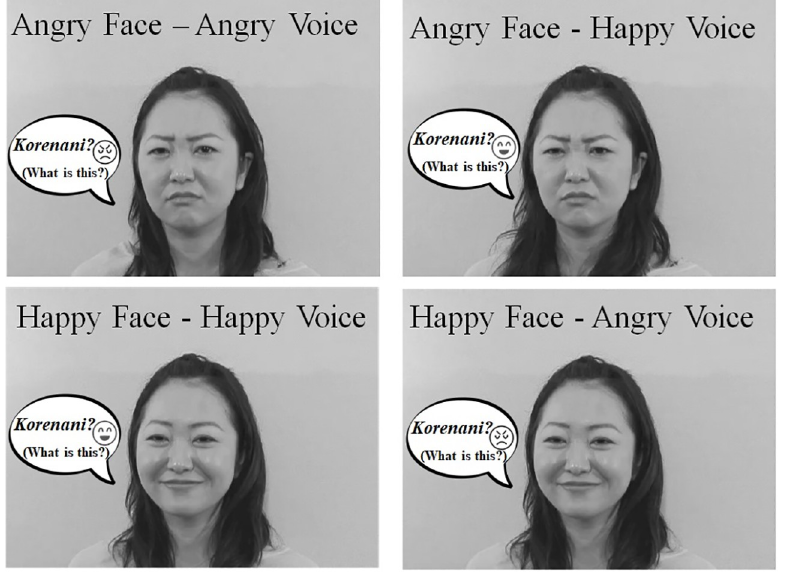
Fig 1. Sample images of stimuli in the emotion perception